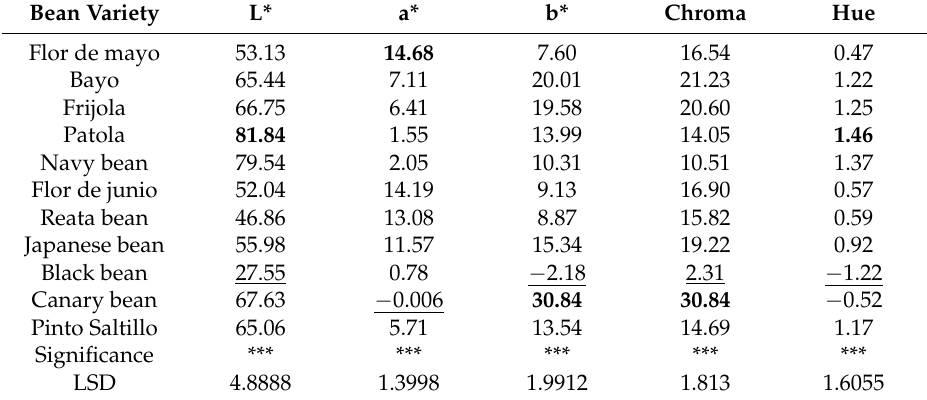
Table 2. Grain color of bean varieties grown in the state of Zacatecas,